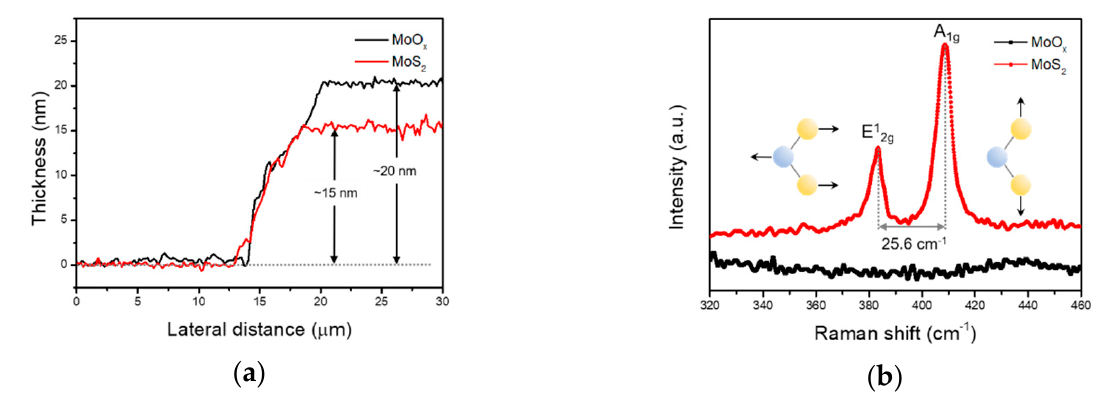
Figure 1. ( a ) Thickness of the MoO x and MoS 2 films measured by AFM are about 20 nm and 15 nm, respectively. ( b ) Comparison of the MoO x and MoS 2 films from Raman spectroscopy. The sulfurized film shows two typical phonon modes, E 12g and A 1g , with peak difference of 25.6 cm − 1 .